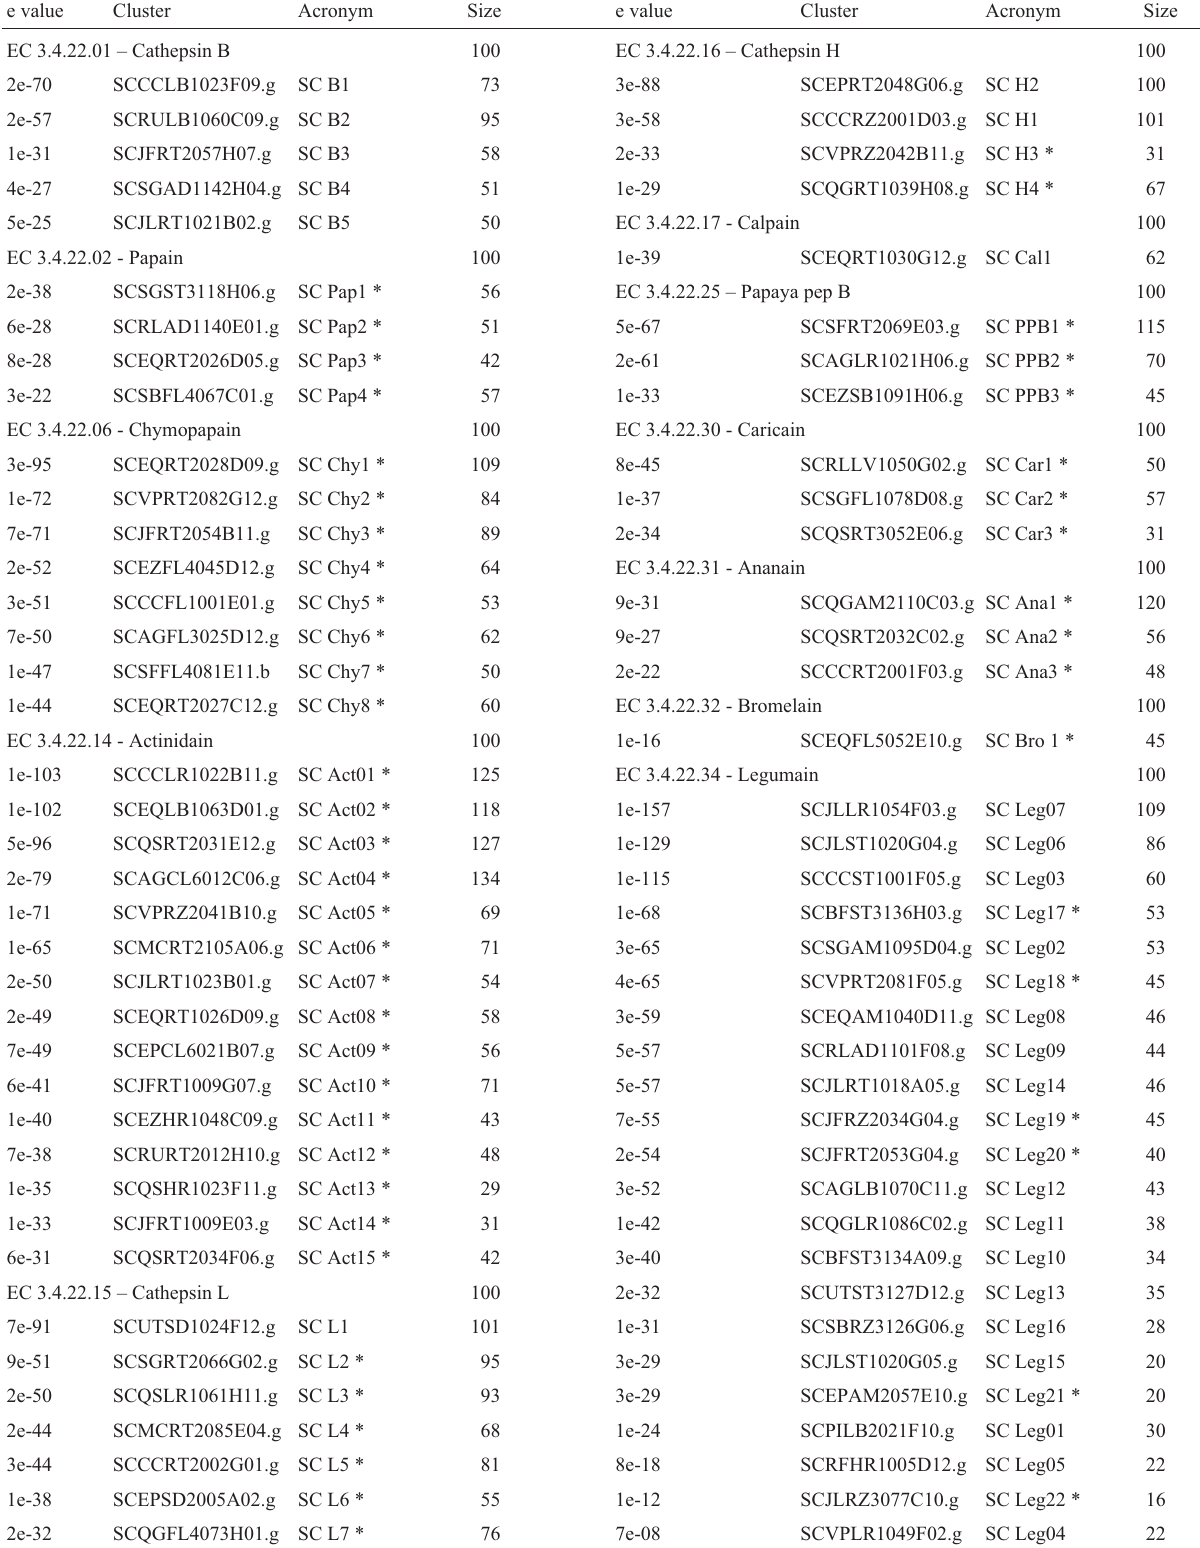
Table III - List of sugarcane cysteine proteinases grouped according to e-values in relation to standard EC